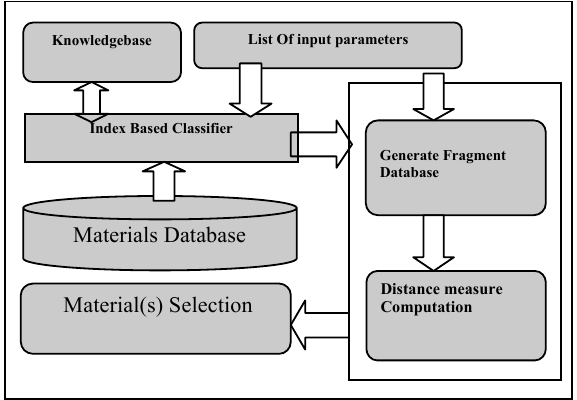
Fig. 2. Composite Material Selection System